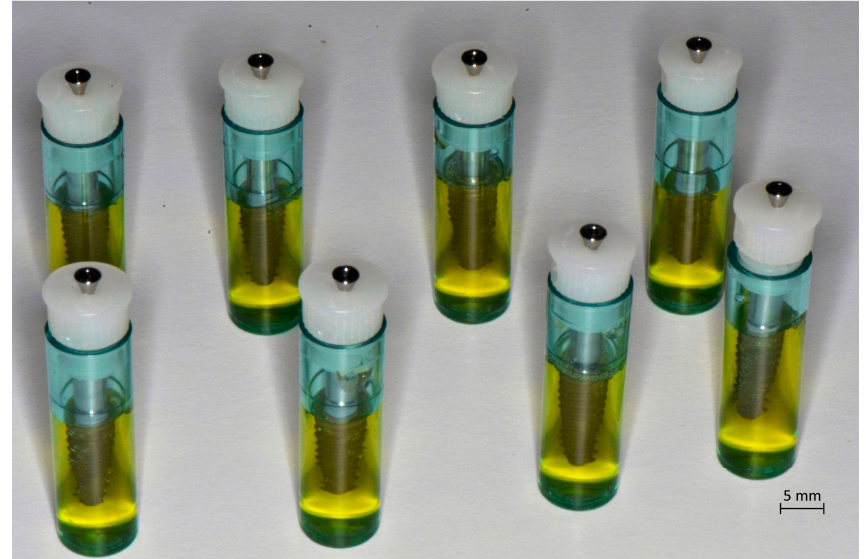
Figure 1. Concentrated Growth Factor (CGF) isolation after using the Silfradent device (Medifuge MF200; Silfradent srl, Forlì, Italy).